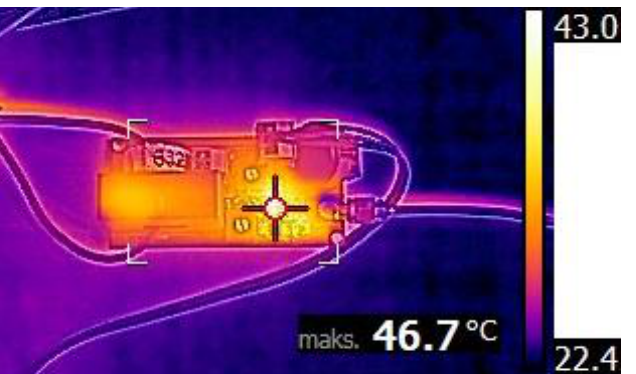
Figure 11 . IR photo of the proposed sensor in steady state operation under a full load current (40 A).